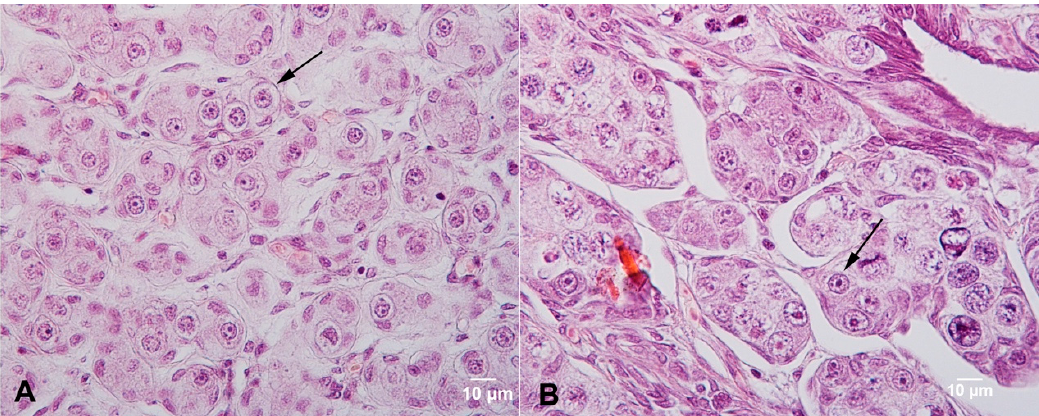
Figure 1. Sterlet Acipenser ruthenus gonads. ( A ) Sterlet testis at maturity stage II (10-month-old); ( A ) showing spermatogonia (black arrow) and Sertoli cells; ( B ) Sterlet ovary in maturity stage II (10- month-old); ( B ) showing oogonia (black arrow) and early oocytes.